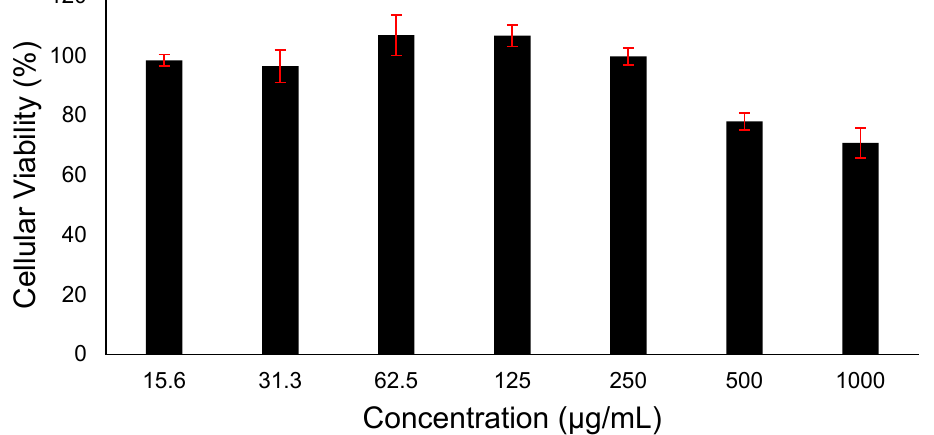
Figure 6. Cell viability of different doses of imeglimin upon 24 h HFF-1 cells exposure. The data demonstrated that imeglimin is safe at ≤ 250 µg/mL. Results are presented as mean ± SD (n = 3).